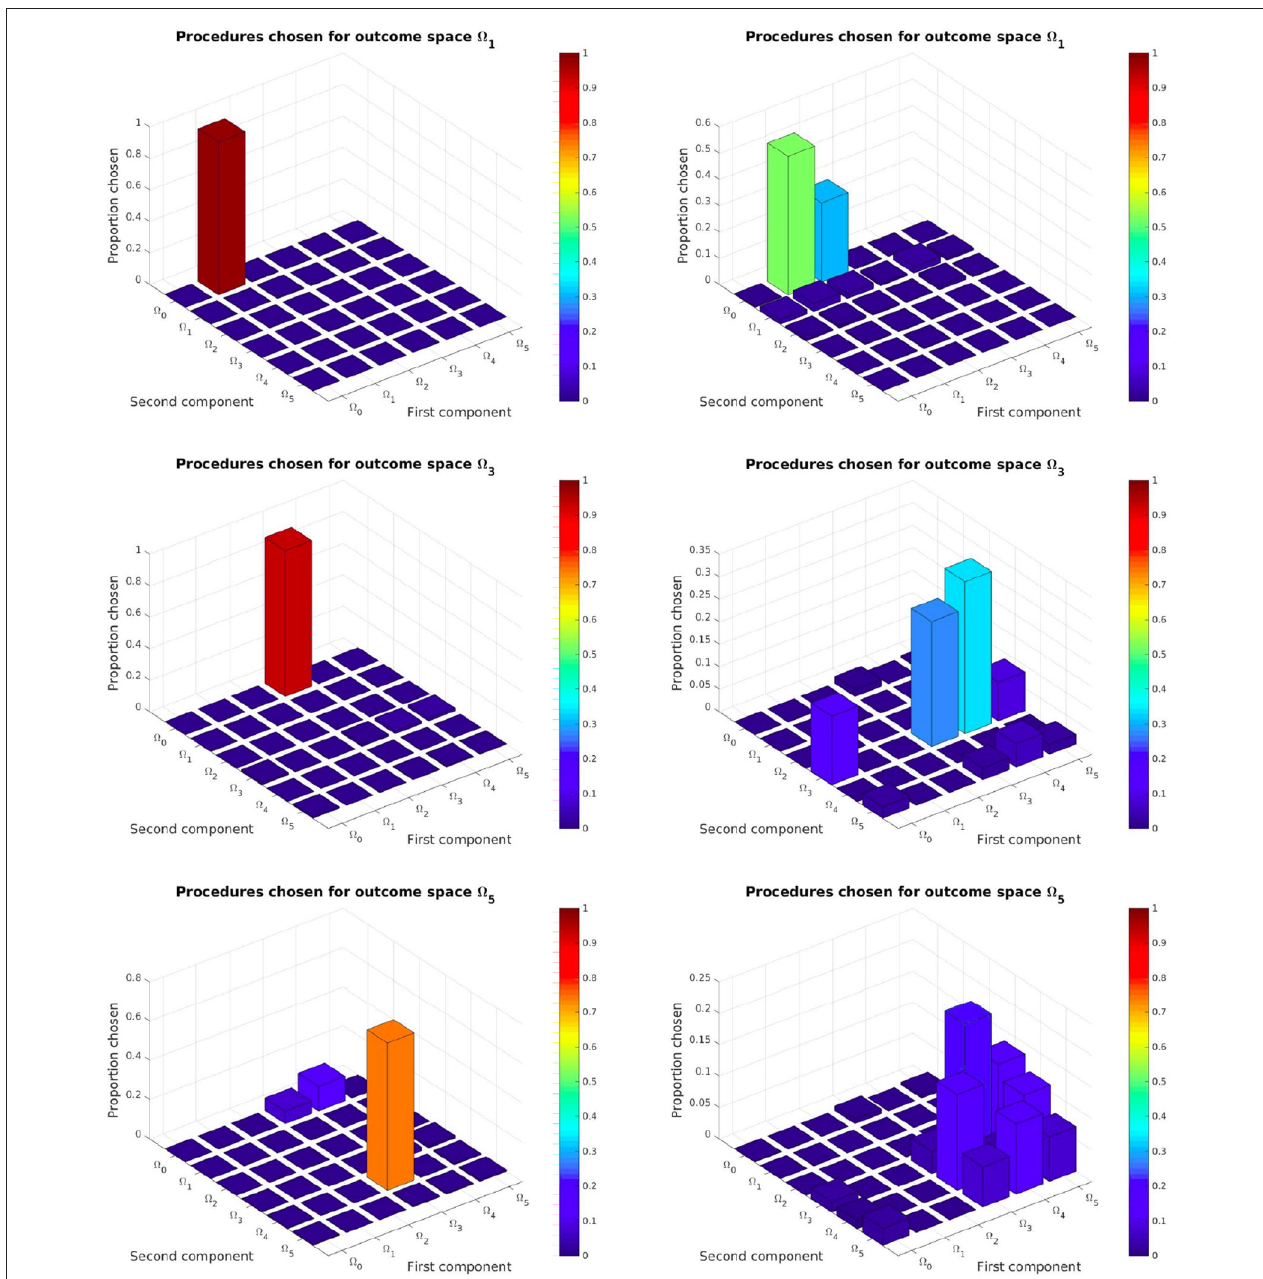
FIGURE 8 | Task hierarchy discovered by the SGIM-PB (left side) and IM-PB (right side) learners for the outcome spaces (cid:127) 1 , (cid:127) 3 , (cid:127) 5 : this represents for each complex outcome space the percentage of time each procedural space would be chosen. See Appendix A for the complete figure on Figure A1